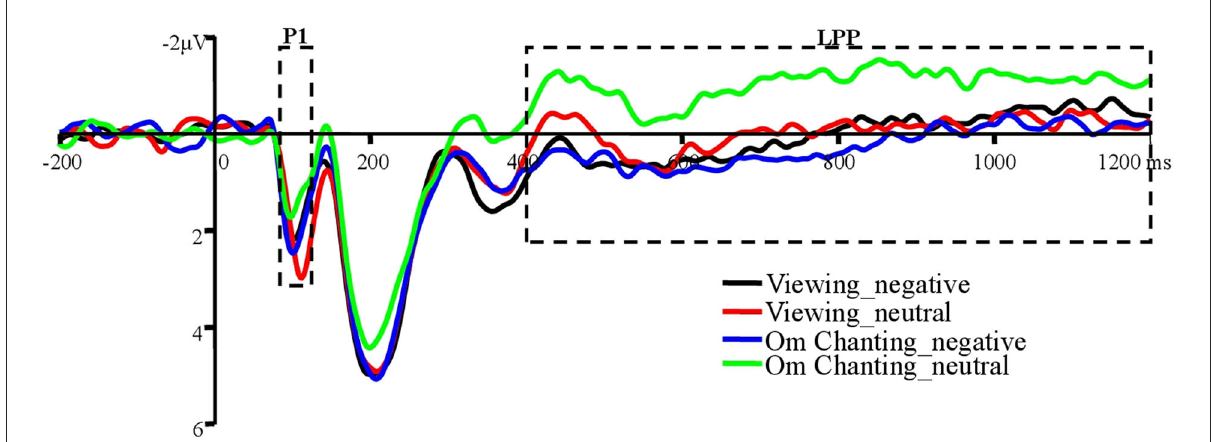
FIGURE2 Grand average ERPs of P1 and LPP to unpleasant and neutral images at the parietooccipital site group (P3, PZ, P4, PO7, POZ, PO8, O1, O2, and Oz).